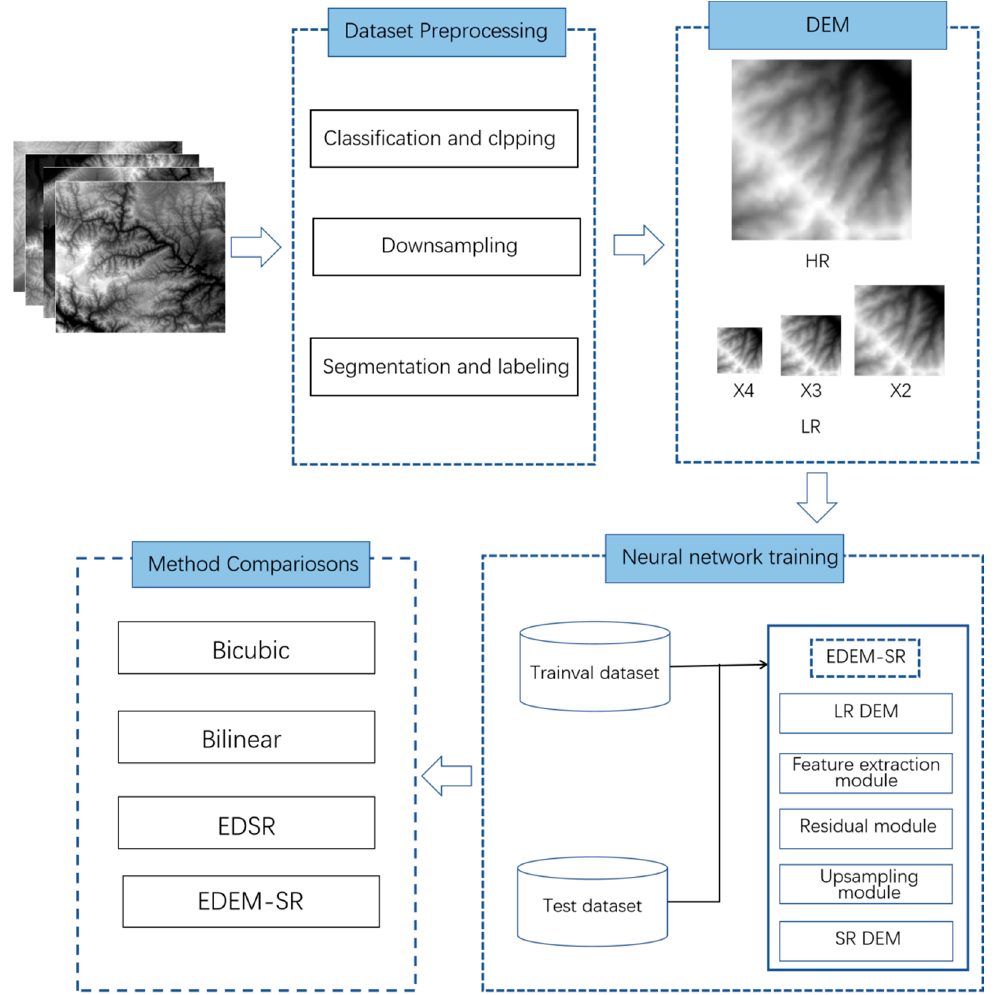
Figure 1. The EDEM-SR workflow.